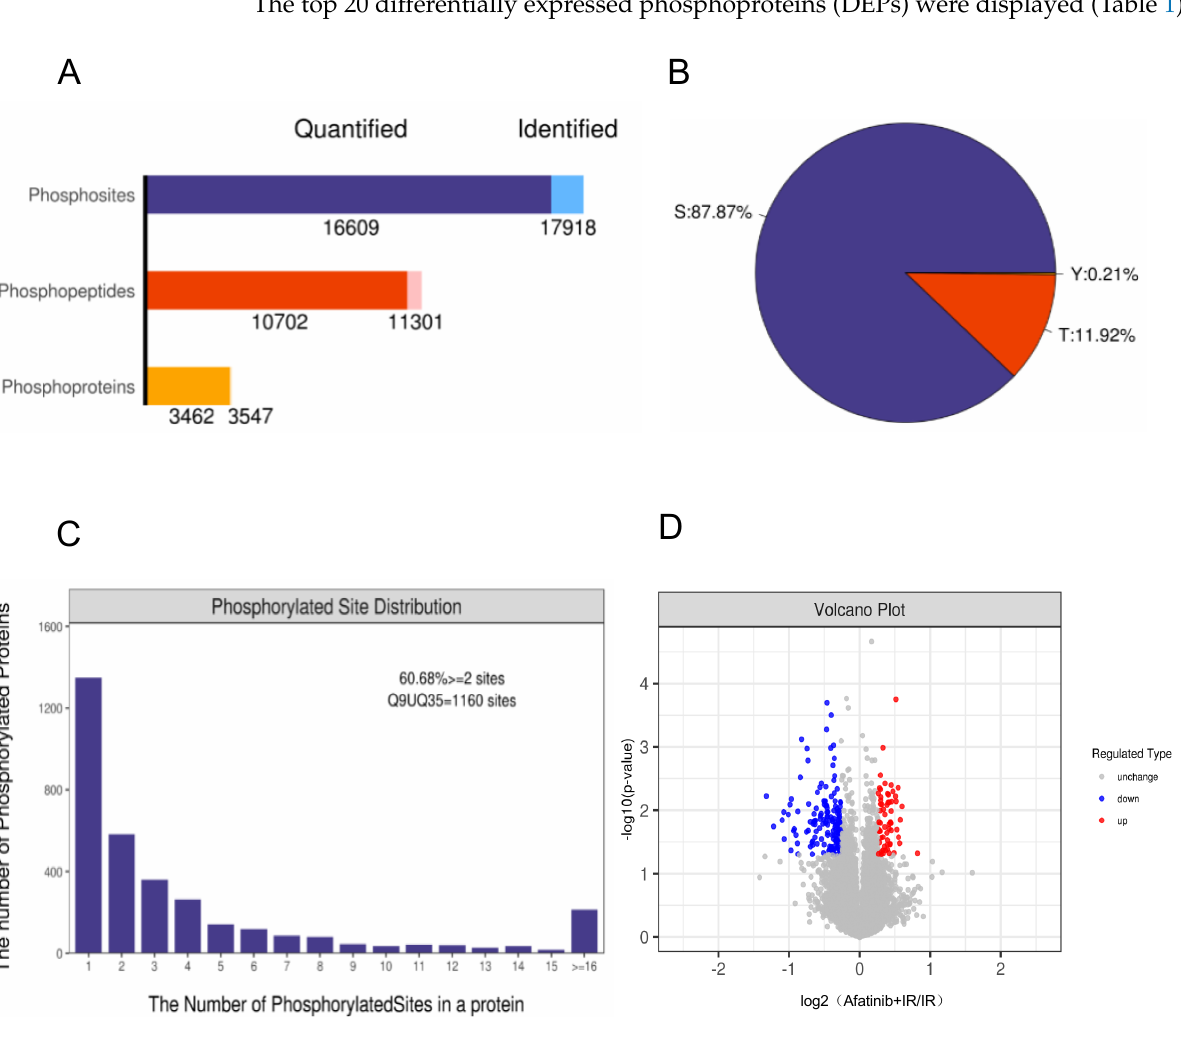
Figure 2. The distribution of phosphorylation sites. ( A ) Distribution of identified and quantified phosphorylated sites, phosphopeptides and phosphoproteins. ( B ) Distribution of phosphorylated sites on serine, threonine, and tyrosine. ( C ) Distribution of phosphorylated sites in a protein. ( D ) Volcano plots of group comparisons (Afatinib + IR vs. IR) showing the adjusted significance p -value (log2) versus fold change (log2). Red dots indicate significantly up-regulated phosphoproteins and blue dots indicate down-regulated. Table 1. Top 20 differentially expressed phosphoproteins (DEPs).